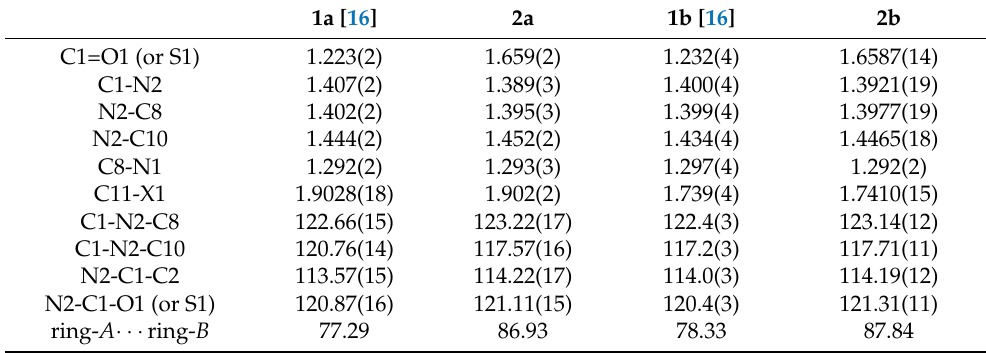
Table 1. Selected bond distances (Å) and angles ( ◦ ) and dihedral angle ( ◦ ) for racemic 1a , 2a , 1b and 2b .